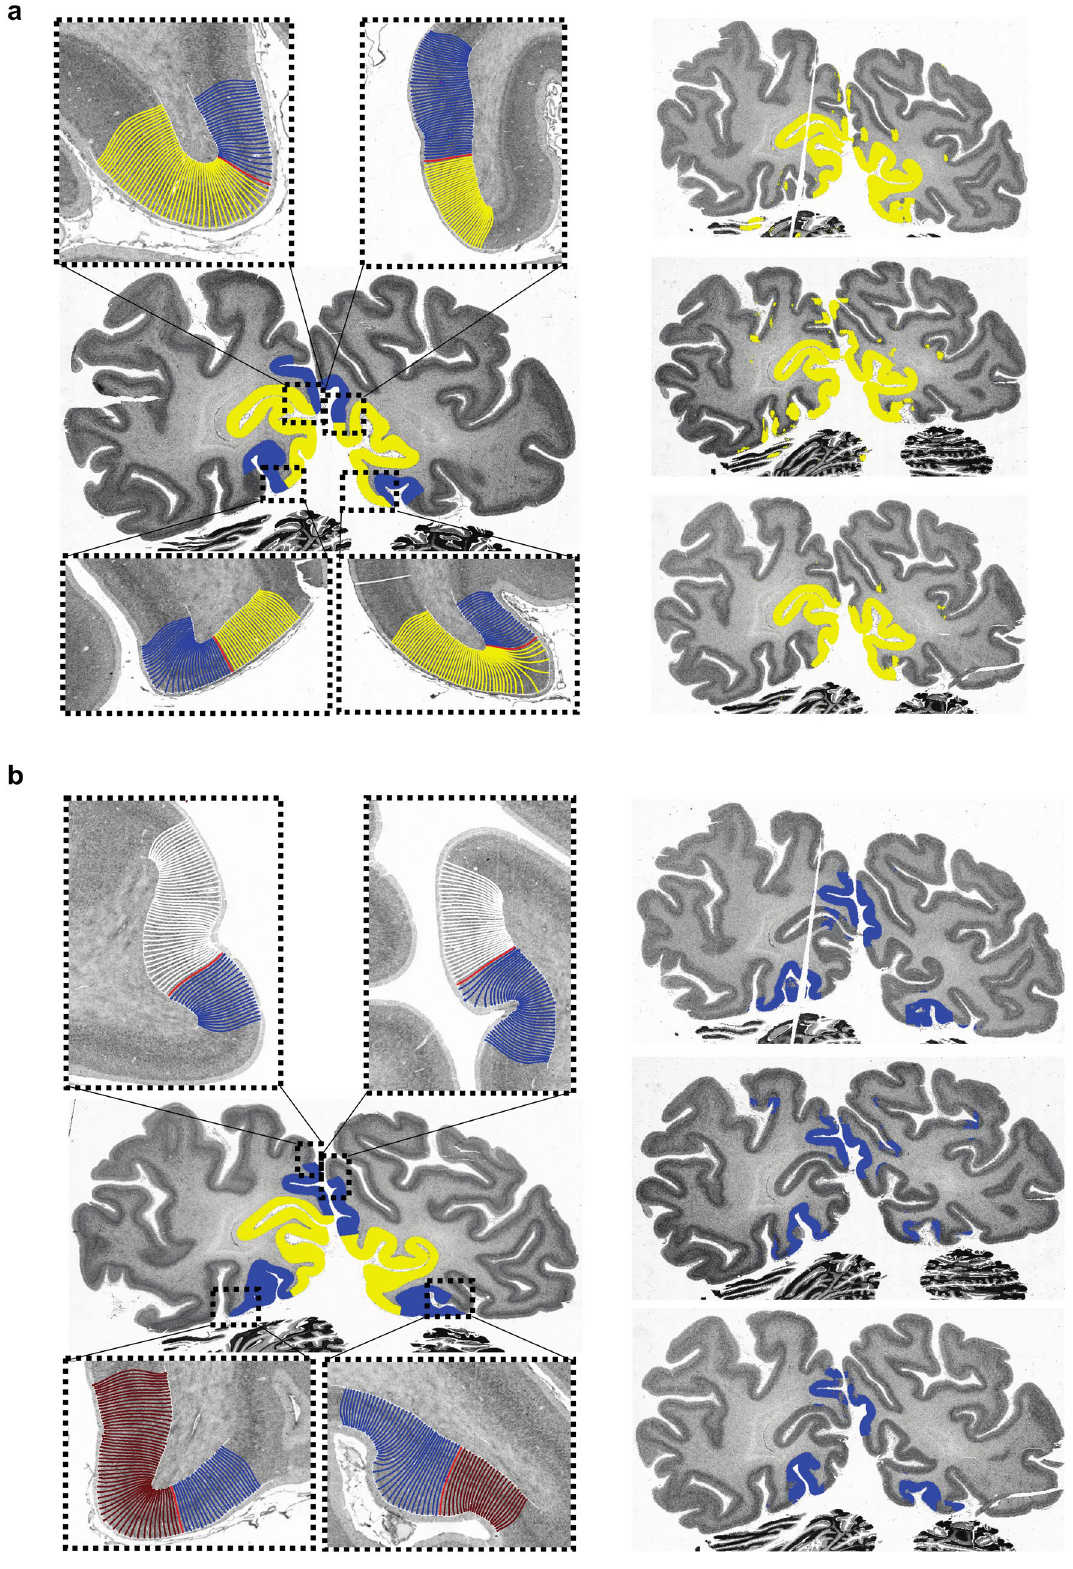
Figure 8. Segmentations of the hOc1 ( a ) and hOc2 ( b ) CNNs on three sections of the BigBrain dataset in comparison to borders detected by the GLI profile approach. Enlarged images of the training section (section 1081) in ( a ) show borders between cortical areas hOc1 (yellow) and hOc2 (blue). Enlarged images of the training section (section 0961) in ( b ) show borders between cortical area hOc2 (blue), hOc3d (white) and hOc3v (brown). Borders were detected using the GLI profile approach. The segmentations on three of the 119 sections (section 0991, 1036, 1066 from top to bottom) in-between the training sections are shown on the right in ( a ) for cortical area hOc1 (yellow) and in ( b ) for cortical area hOc2 (blue) for a